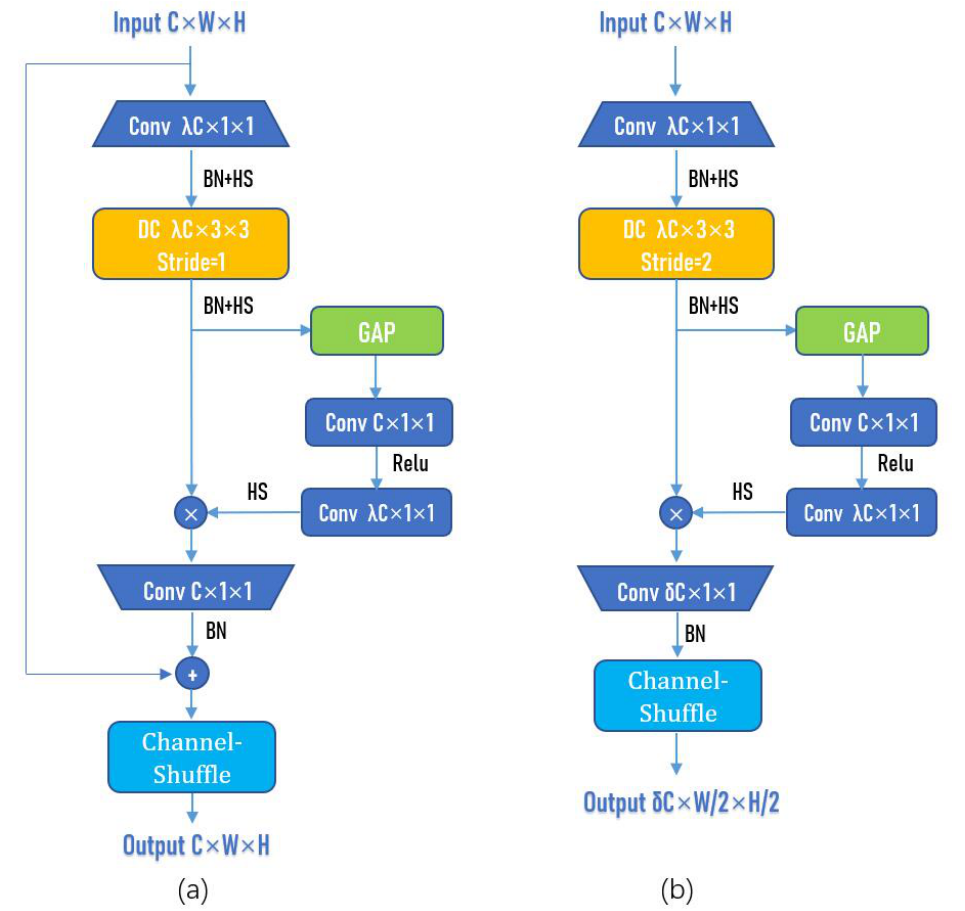
Figure 2. Structure of ASIR-Block. ( a ) ASIR-Block-1. ( b )